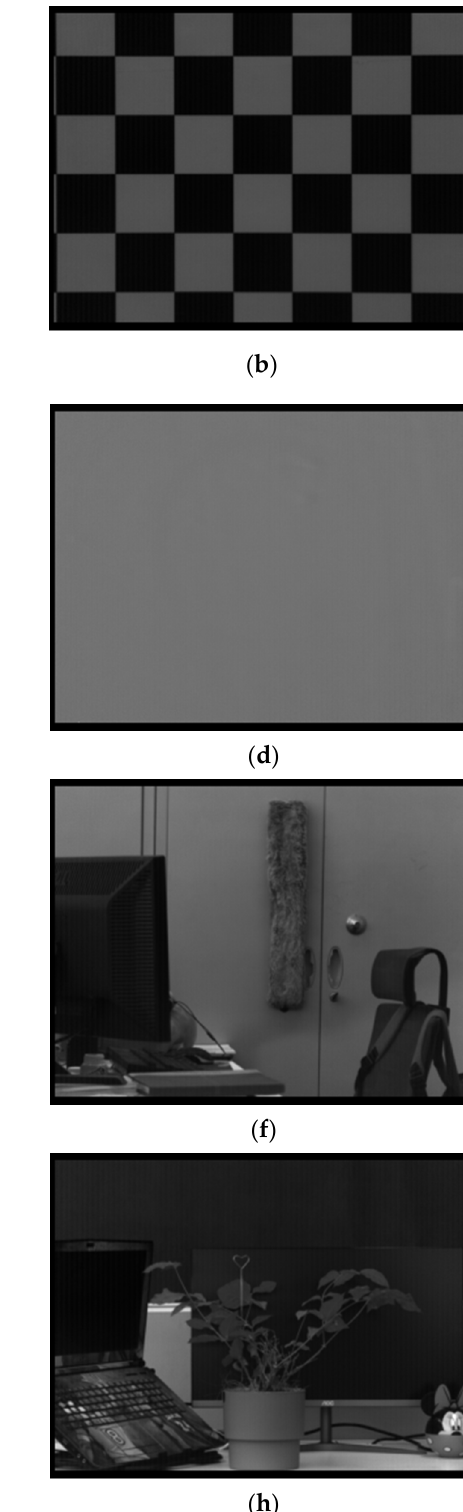
calibration, while images (b), (d), (f) and (h) are captured after calibration. while images ( b , d , f , h ) are captured after